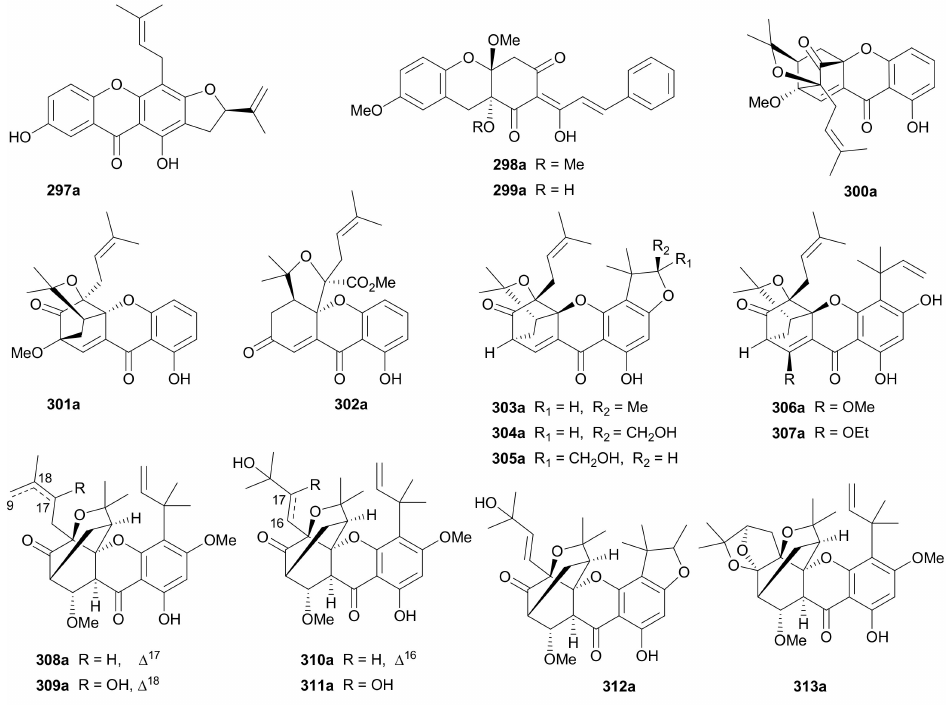
Figure 17. Structures of